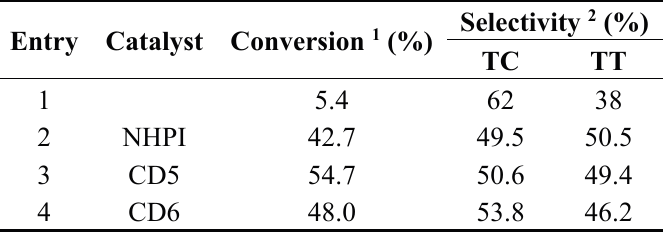
Figure 1. ESI-MS spectra in positive mode of CD3 ( a , b ); CD4 ( c , d ); CD5 ( e , f ); CD6 ( g , h ). Table 1. Methyl linoleate oxidation under O 2 (1 atm) at 28 °C. Conditions: 5 mmol of